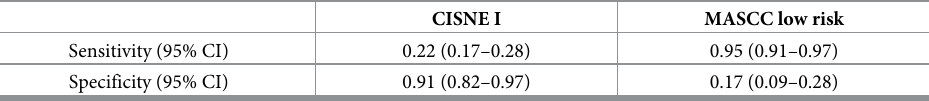
Table 4. Sensitivity and specificity of CISNE I and MASCC low risk in predicting no serious complications. The MASCC has high sensitivity but very low specificity. By contrast, the CISNE has high specificity but very low sensitivity.